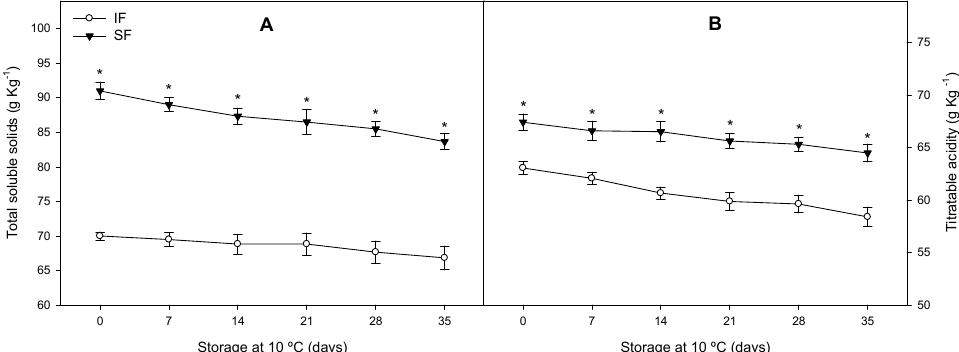
Figure 3. Effect of standard fertigation (SF) and intensive fertigation (IF) on total soluble solids ( A ) and titratable acidity ( B ) in lemon fruits stored for 35 days at 10 °C. Asterisks (*) show significant di ff erences between lemon fruits cultivated with IF and those with SF at p < 0.05.